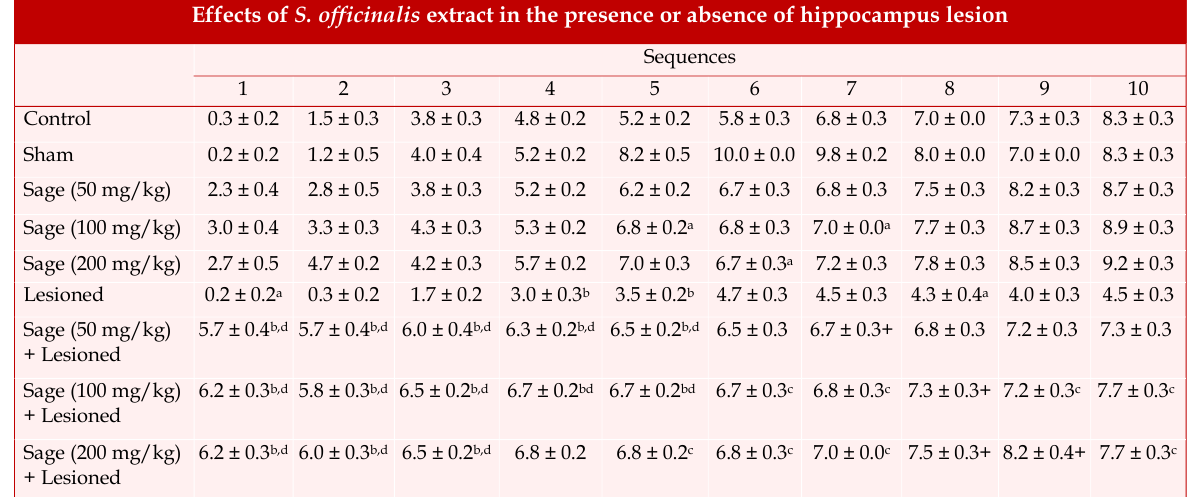
Effects of S. officinalis extract in the presence or absence of hippocampus lesion